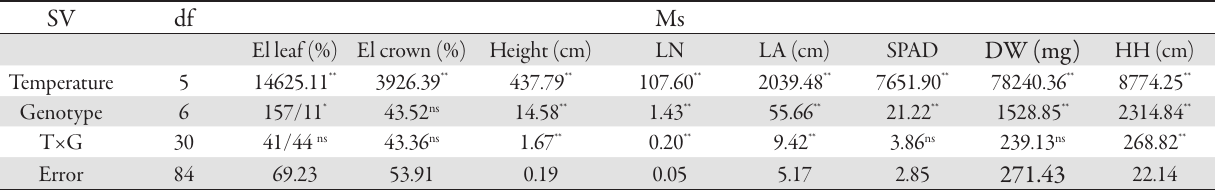
Tab. 1. Source of variation (SV), degree of freedom (df) and mean square (Ms) of measured plant parameters exposed to different freezing temperature and recovery in greenhouse of different triticale genotypes